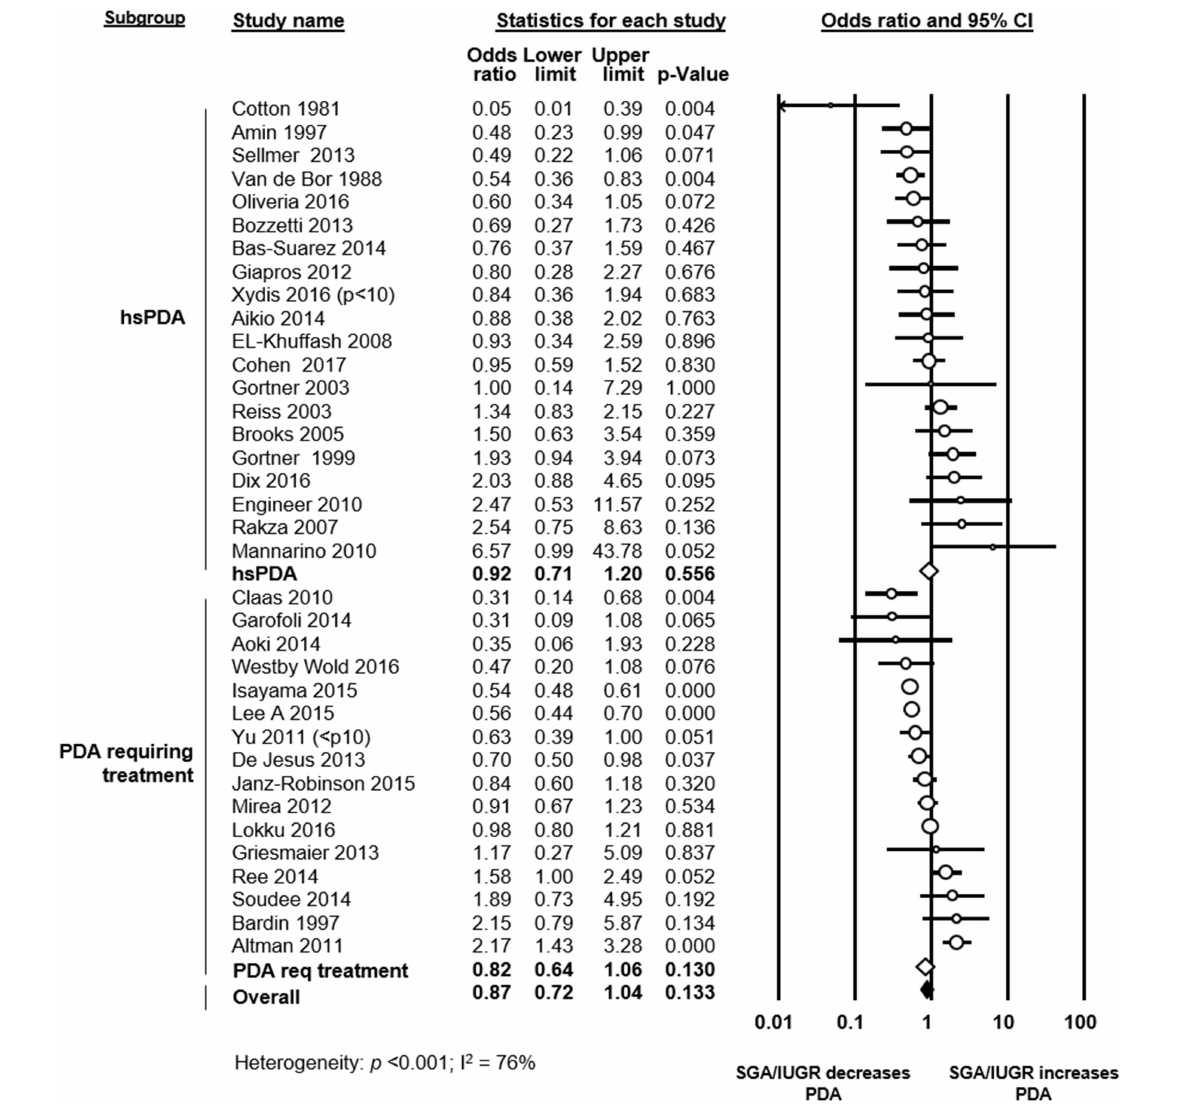
FIGURE 2 | Subgroup meta-analysis of studies using a definition of significant patent ductus arteriosus (PDA) (i.e., hemodynamically significant PDA or PDA requiring treatment). Analysis on the association of growth restriction and PDA. Req: requiring; CI: confidence interval; SGA: small for gestational age; IUGR: intrauterine growth restriction; hsPDA: hemodynamically significant